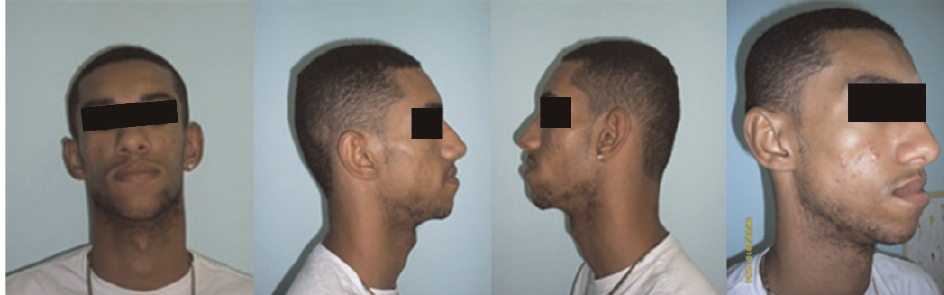
Figure 1 - patient with facial lipoatrophy associated with HIV.